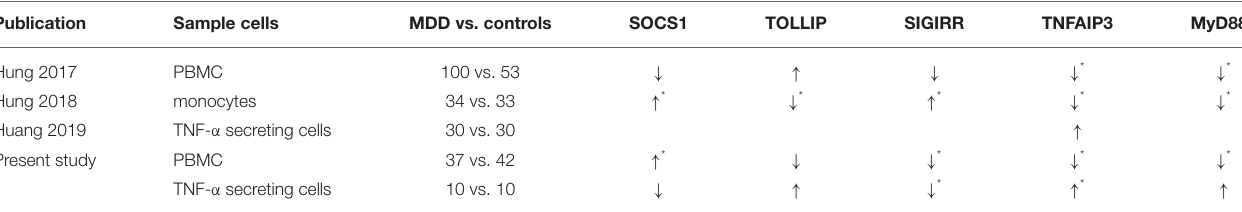
TABLE 4 | Summary of recent findings of negative regulators of TLR pathway (- 1